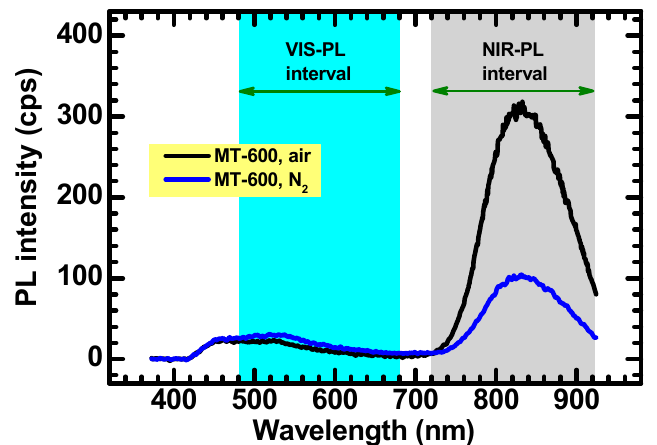
Figure 11. PL spectra of the MT ‐ 600 sample acquired in air (black curve) after 20 min exposure to flowing N 2 (300 sccm flow): The spectra are acquired at room temperature. The wavelength interval used as definition for “VIS ‐ PL” and “NIR ‐ PL” are highlighted.